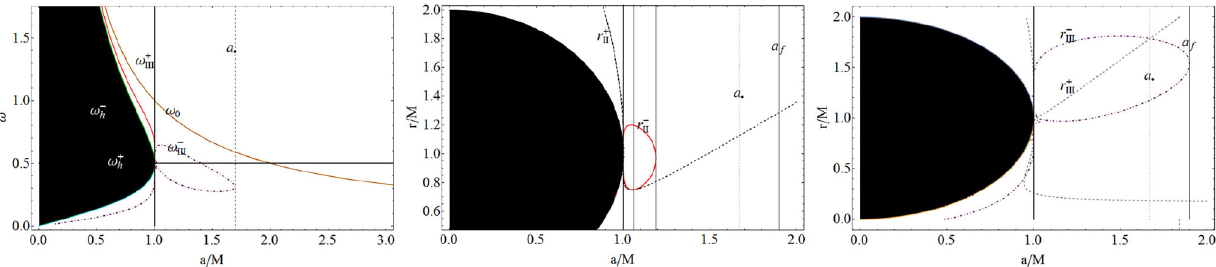
Fig. 5 Center-rightpanels.Theradii r ± 0 and ∂ 3 r ω ± = 0, respectively, are shown as functions of the spin a / M . Black regions correspond to r < r ± . Left panel: The frequencies ω ±